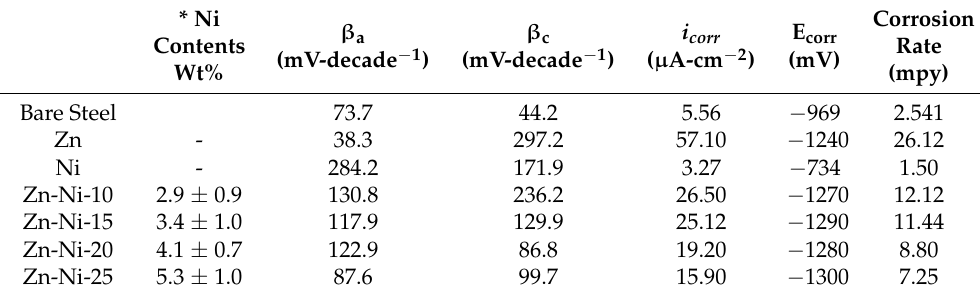
Table 2. Kinetic parameters of bare steel, Zn, Ni and Zn-Ni alloy coating in 3.5 wt.% NaCl solution.